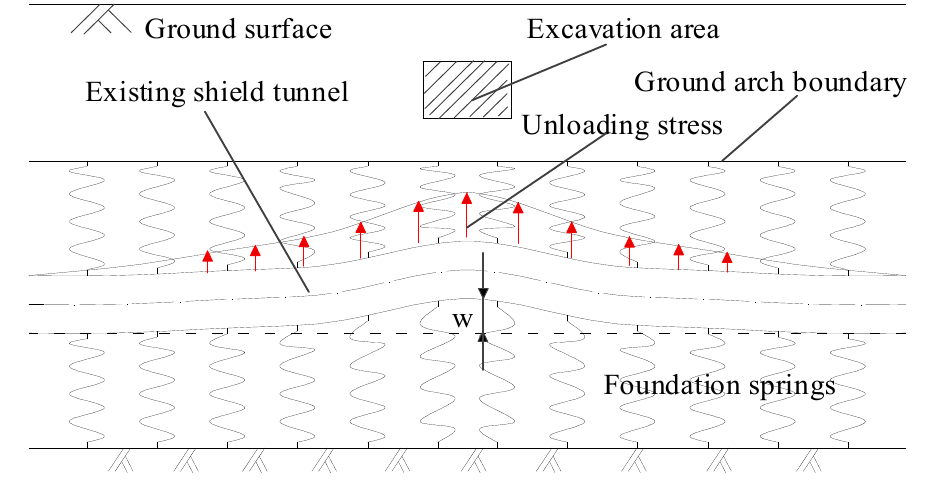
Figure 2. Double-sided elastic foundation beam model for deep tunnel.